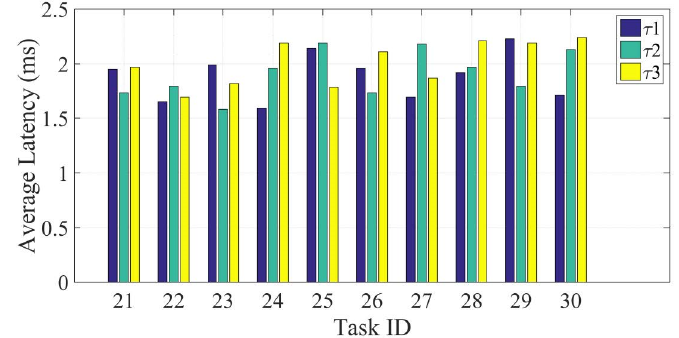
Figure 12. The average latency of handling the third group of tasks.